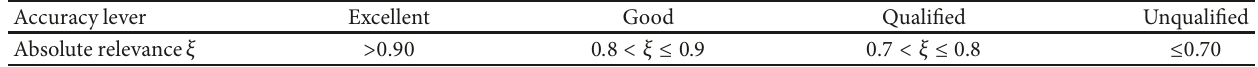
Table 1: Classification of relevance